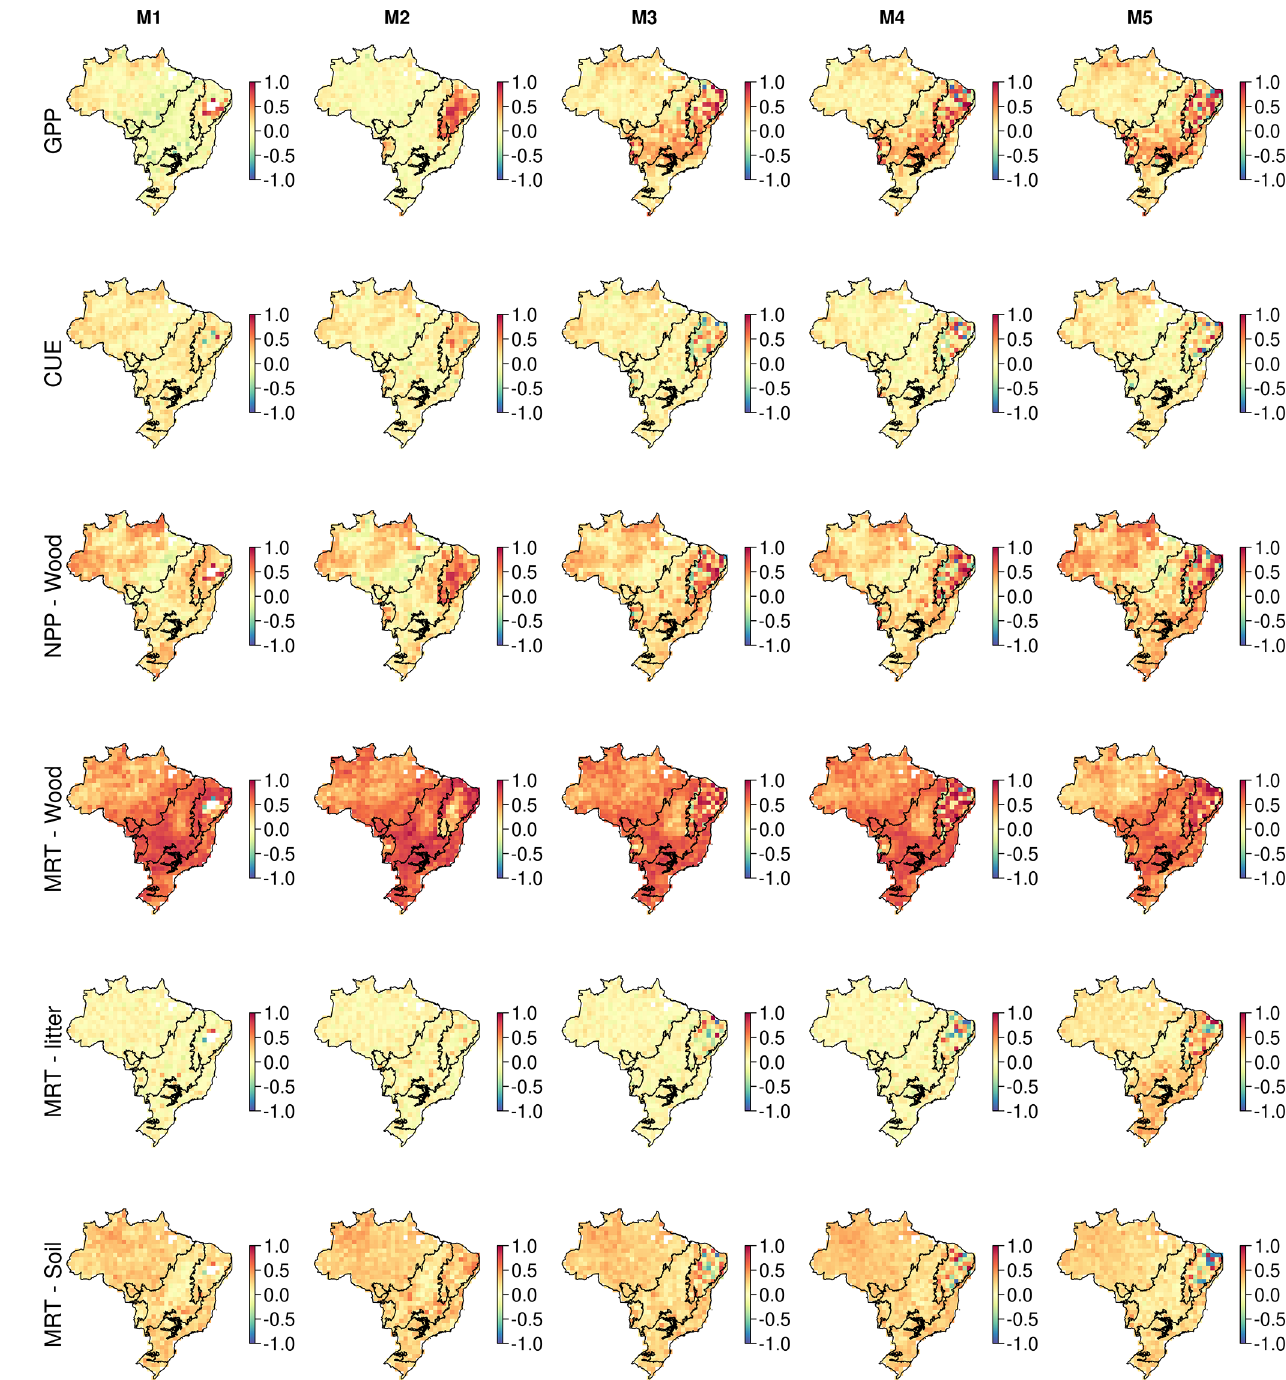
Figure A18. Correlation maps between the simulated change in biomass stocks (SSP2-4.5; 2001–2100) and ecosystem variables. These maps identify spatial variation in the sensitivity of biomass change to key ecosystem variables. Correlates are pool-specific MRT (years), NPP (gCm − 2 d − 1 ), CUE (1 − R a : GPP) and GPP (gCm − 2 d − 1 ) estimated across the whole simulation period.